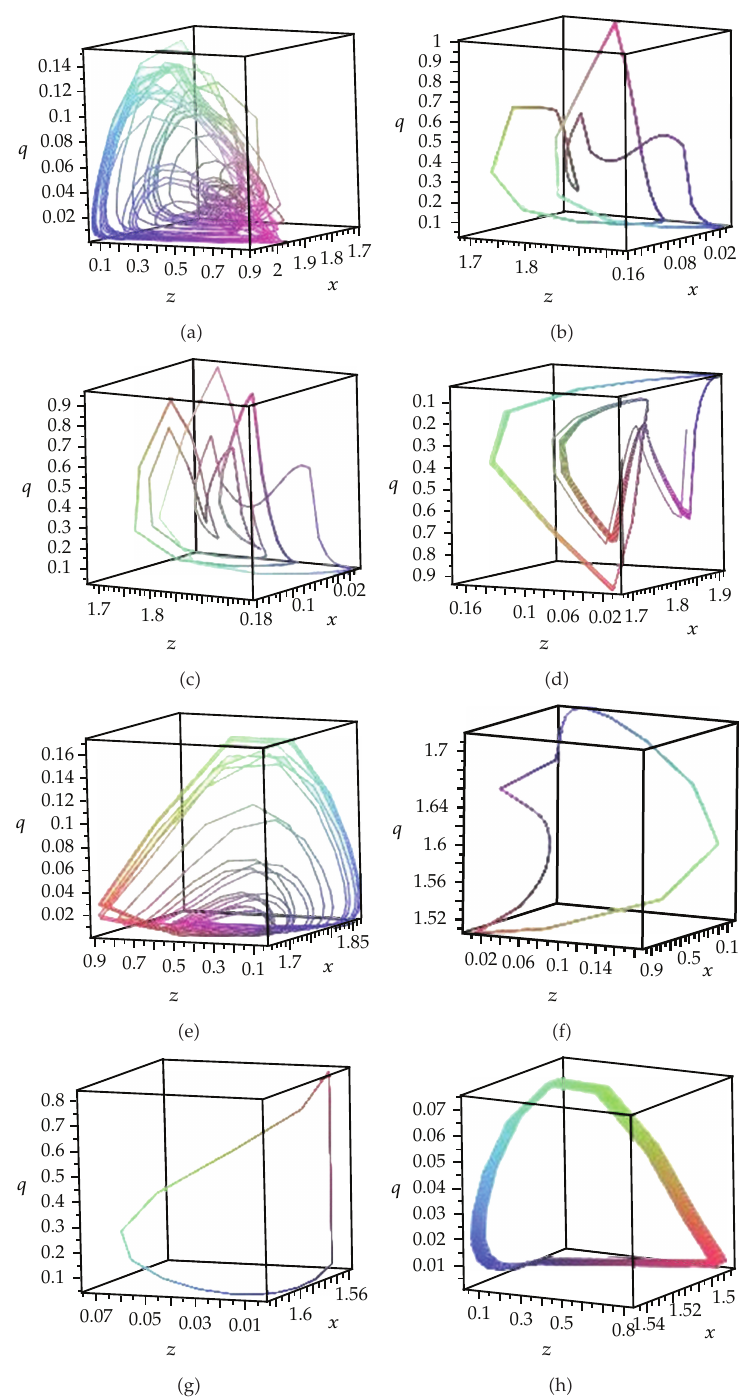
Figure 6: Periodic and chaotic behavior corresponding to Figure 3, as shown in phase diagrams: (cid:2) a (cid:3) p (cid:7) 0 . 13, (cid:2) b (cid:3) p (cid:7) 0 . 25, (cid:2) c (cid:3) p (cid:7) 0 . 3, (cid:2) d (cid:3) p (cid:7) 0 . 35, (cid:2) e (cid:3) p (cid:7) 0 . 45, (cid:2) f (cid:3) p (cid:7) 0 . 7, (cid:2) g (cid:3) p (cid:7) 0 . 9, and (cid:2) h (cid:3) p (cid:7) 1 .